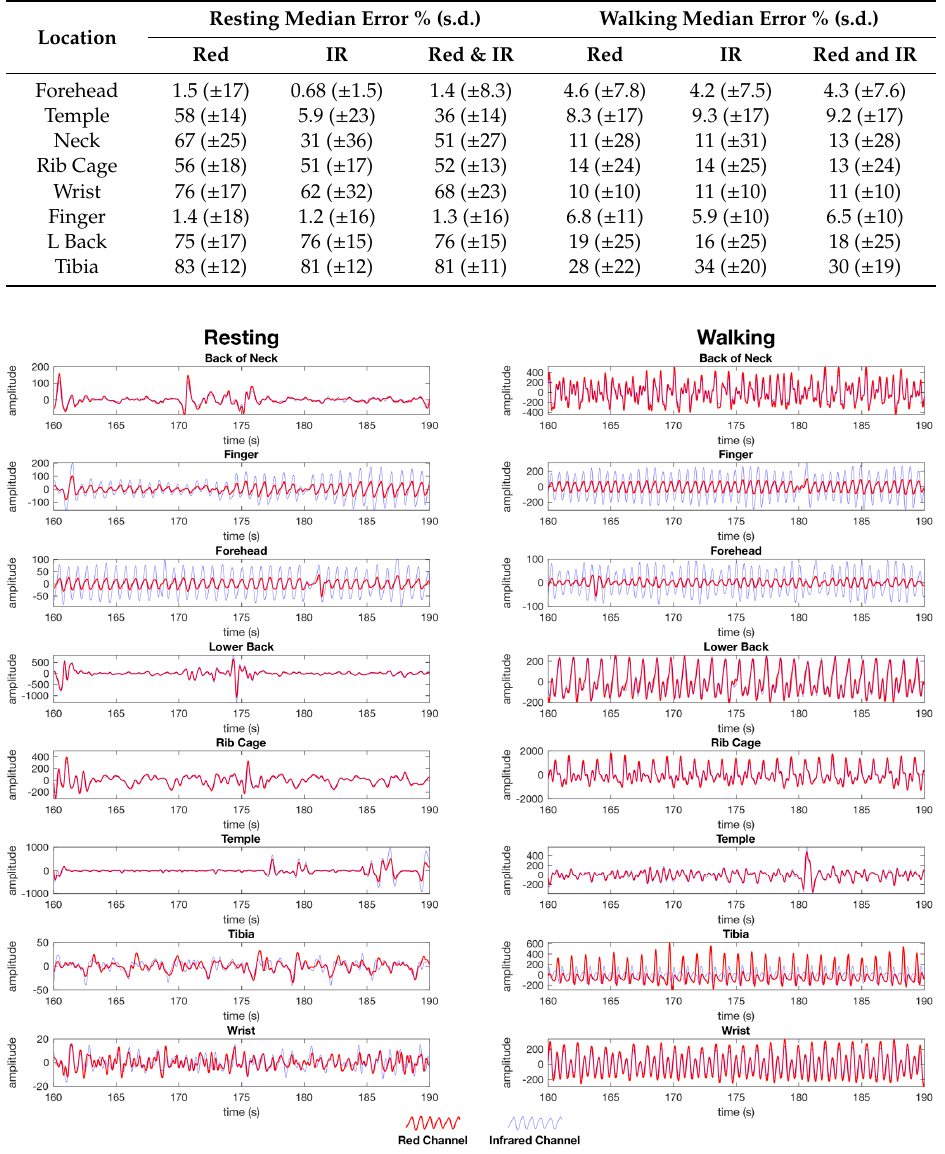
Figure 7. Post processed PPG waveforms used for heart rate and SpO 2 calculation from the female dataset showing the red channel waveform (red) and the infrared channel waveform (blue) for both the resting (left) and walking (right) tests. The data is presented as the same randomly selected 30 second window of data from the same dataset for each location. Each anatomical location where the PPG sensors were simultaneously placed are represented, back of the neck, finger, forehead, lower back, rib cage, temple, tibia, and wrist. The y-axis units are arbitrary as the calculation of heart rate is performed on a time between peaks, whereas SpO 2 is calculated as a ratio between the red and IR channels as set out in the materials and methods section.